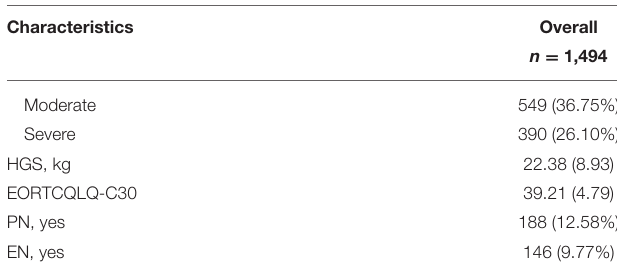
TABLE 1 | Baseline characteristics of the study